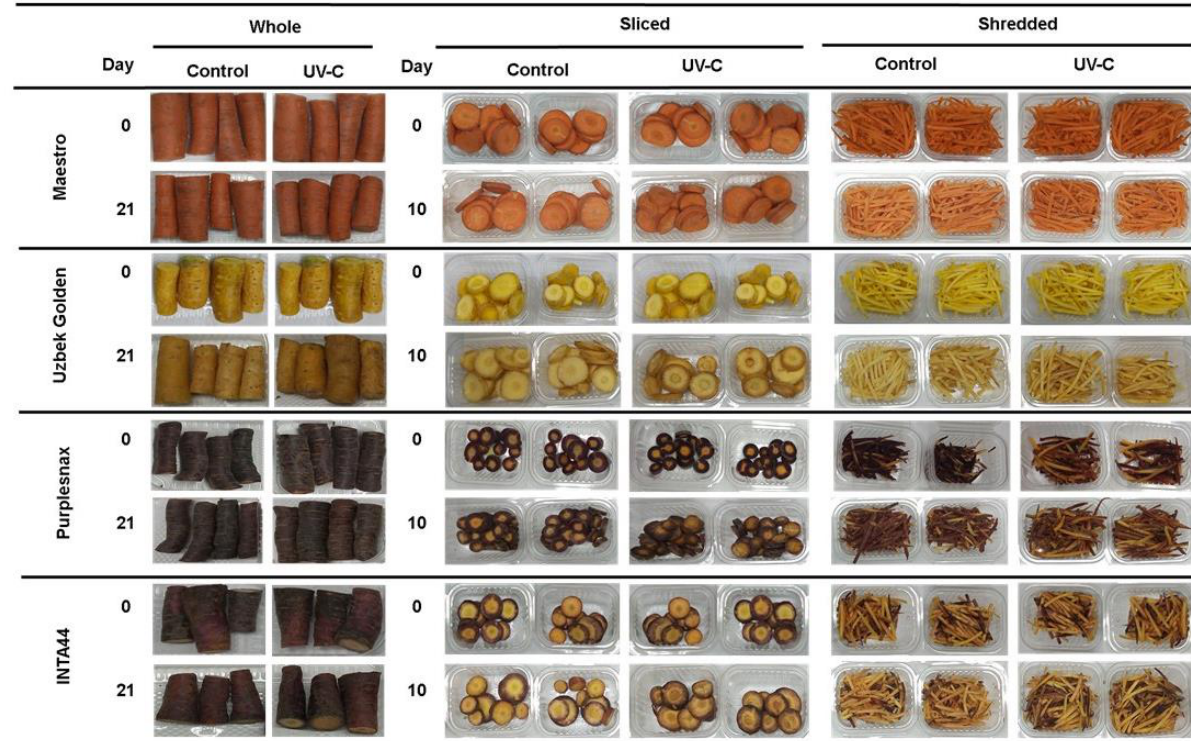
Figure 6. Appearance of UV-C treated and untreated (control) whole, sliced, and shredded root samples of orange (cv. Maestro), yellow (Uzbek Golden), and purple-rooted carrots (Purplesnax and INTA44), before the UVC treatment (day 0) and 10 (sliced roots) and 21 (whole roots) days after the UVC treatment and stored at 5 °C. Table 2. Percentage of weight loss, visual browning index, and color change (∆E) values in UV-C treated and untreated (Control) whole, sliced, and shredded root samples after 10 (for sliced and shredded roots) and 21 days (for whole roots) of cold storage, for orange (cv. Maestro), yellow (Uzbek Golden), and purple-rooted carrot accessions (Purplesnax and INTA44). Whole Sliced Shredded UV-C UV-C